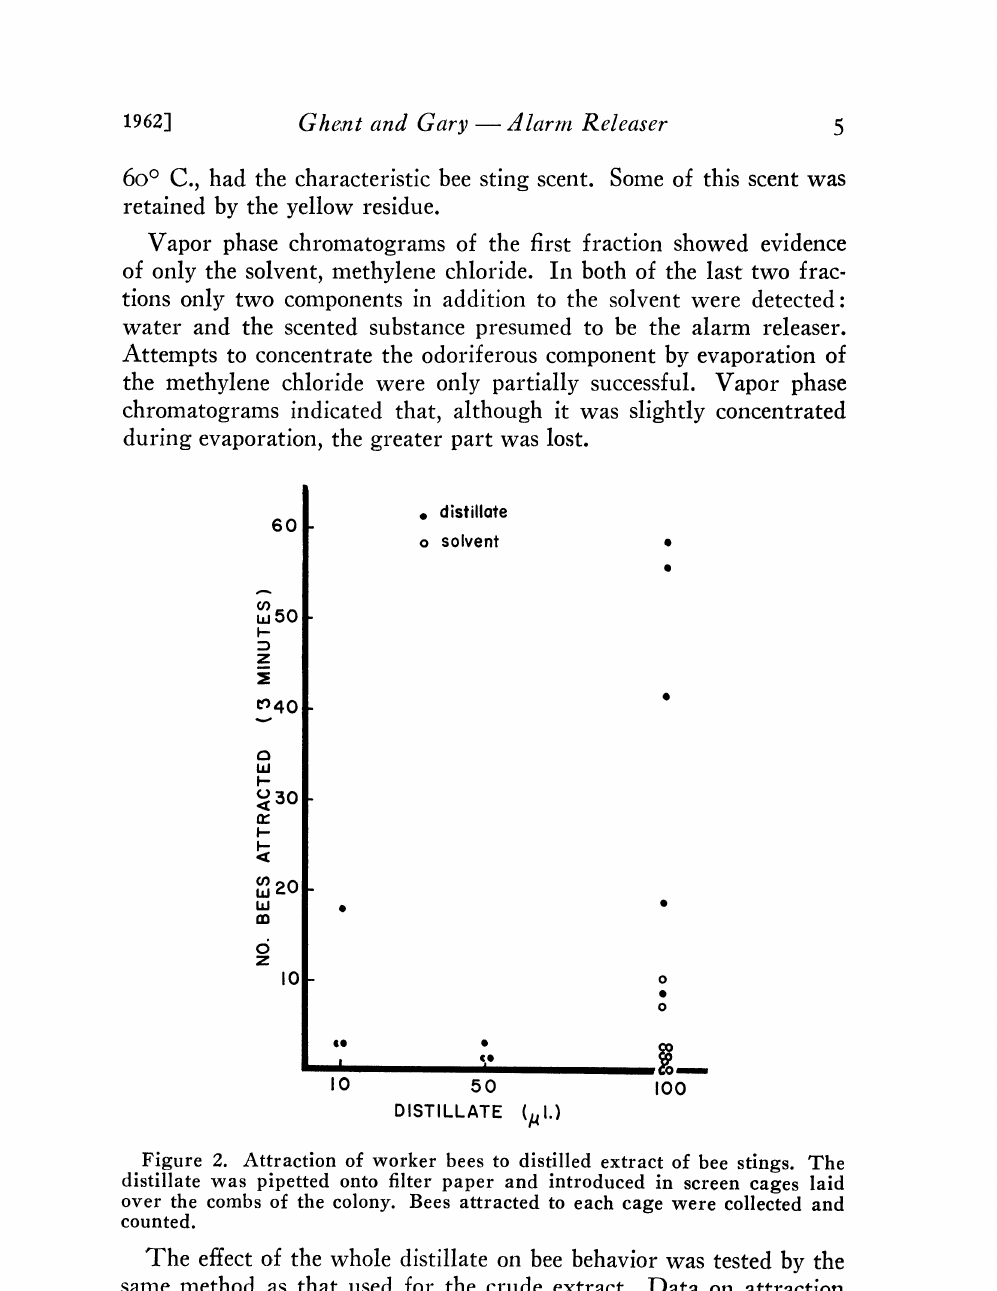
Figure 2. Attraction ot worker bees to distilled extract ot bee stings. The distillate was pipetted onto filter paper and introduced in screen cages laid over the combs of the colony. Bees attracted to each cage were collected and